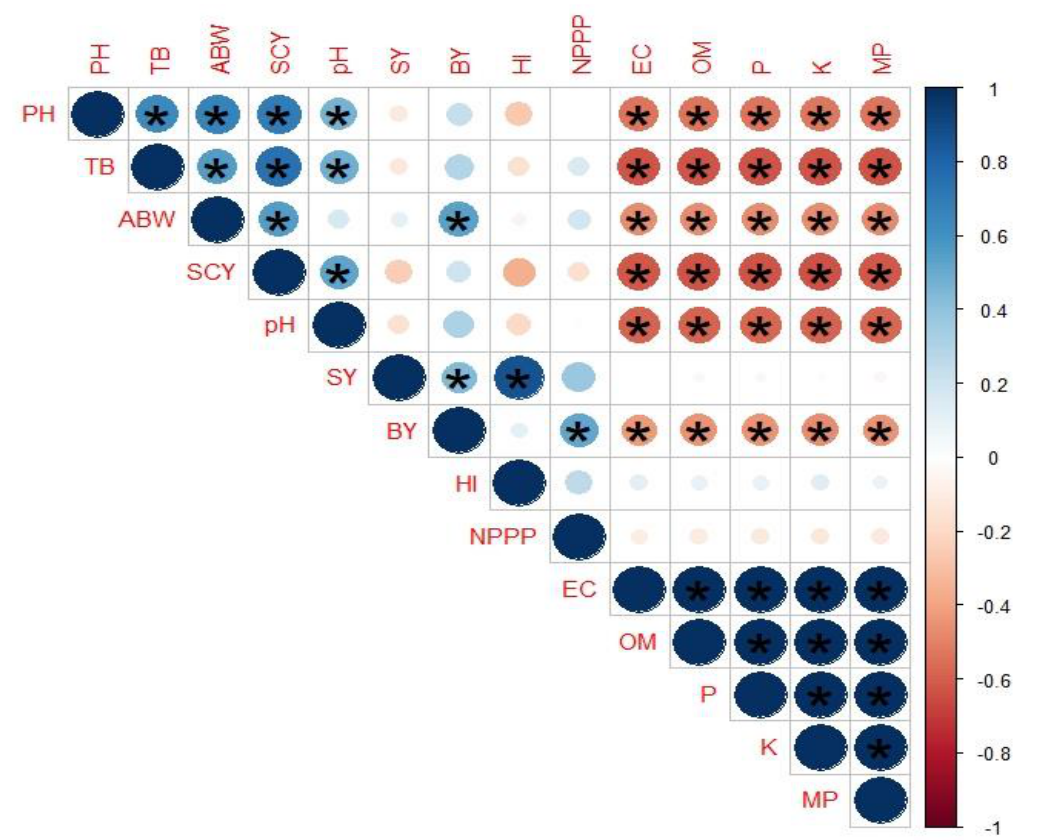
Figure 6. Correlation of growth, yield and physiological attributes of cotton crop, yield components of legume intercrops and soil health indicators under different tillage systems and legume intercrops; the areas of circles show the absolute value of corresponding correlation coefficients tested at * 0.01 significant level. PH = Plant height; TB = Total bolls per plant; ABW = Average boll weight; SCY = Seed cotton yield; BY = Biological yield; HI = Harvest index; NPPP = Number of pods per plant; EC = Electrical conductivity; OM = Organic matter; P = Soil available phosphorus; K = Soil available potassium; MP = Microbial population; pH = soil pH; SY= seed yield.